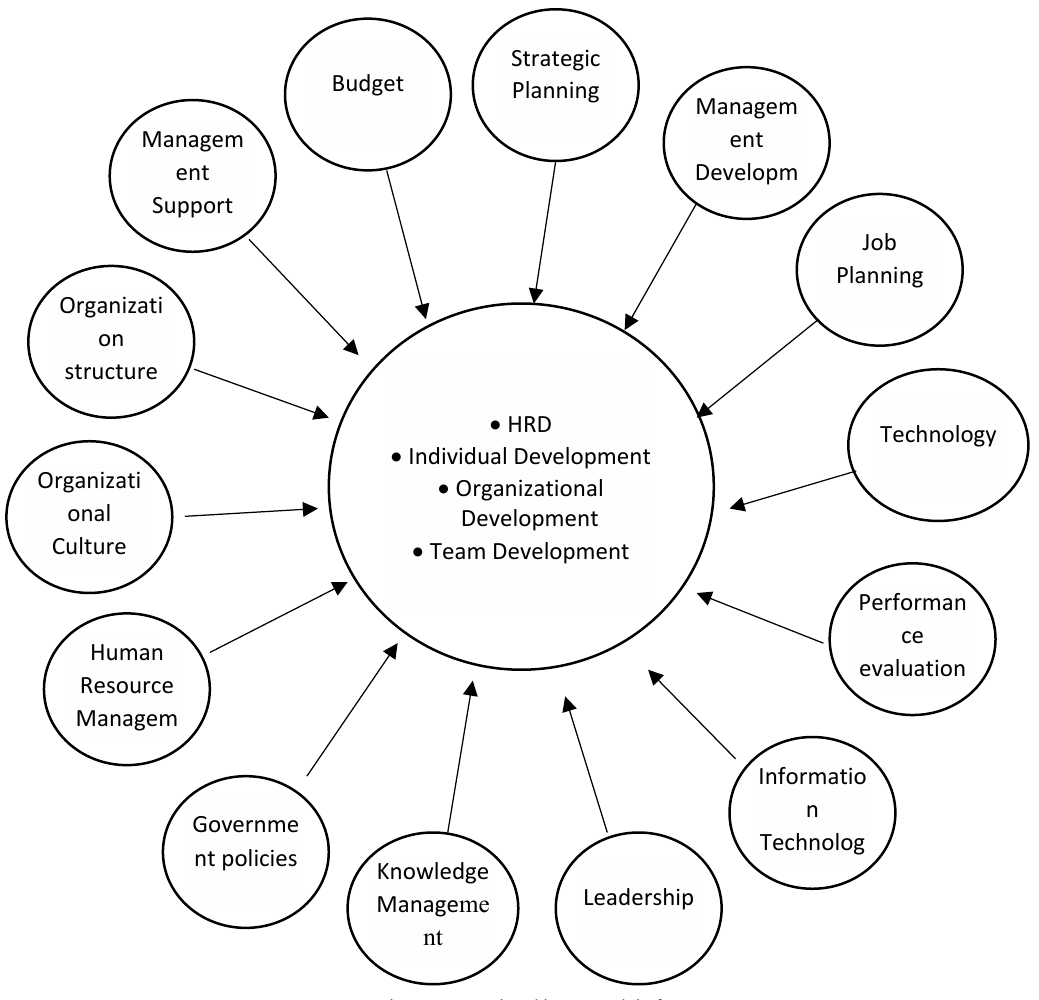
Fig. 1. The conceptual and basic model of Fig. 1: The conceptual and basic model of HRD